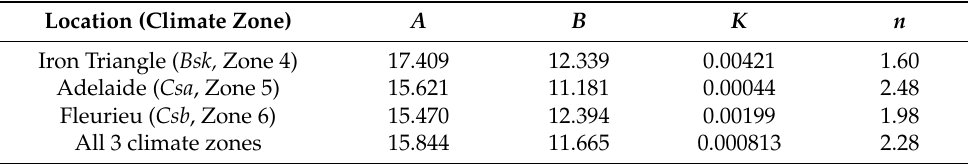
Table 3. Best fit constants for Equation (1).